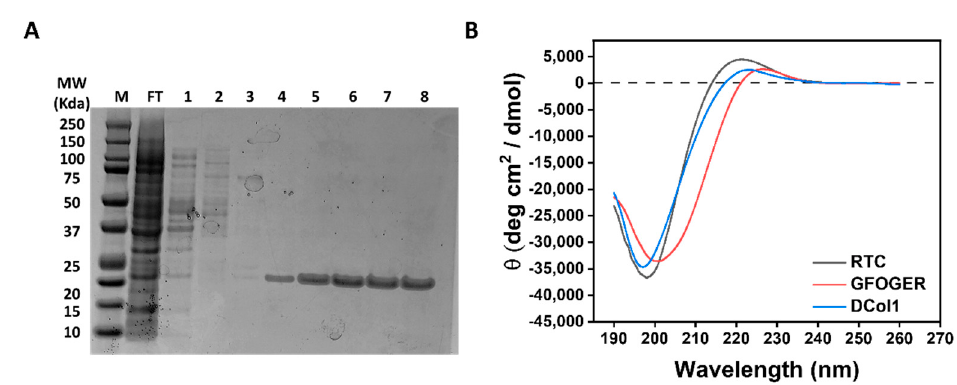
Figure 1. Protein characterization. ( A ) SDS-PAGE analysis of the purification of DCol1 by nickel- affinity chromatography. Lanes: M, molecular weight markers; FT, flow through; 1–2, wash fractions with 60 mM imidazole; 3–4, elution fractions with 250 mM imidazole; 5–8 elution fractions with 1 M imidazole. ( B ) CD spectra at 4 °C of RTC (grey), DCol1 (blue) and GFOGER peptide (red). The vertical axis measures mean residue ellipticity θ in degrees cm 2 dmol − 1 . CD data were collected between 190 and 260 nm.